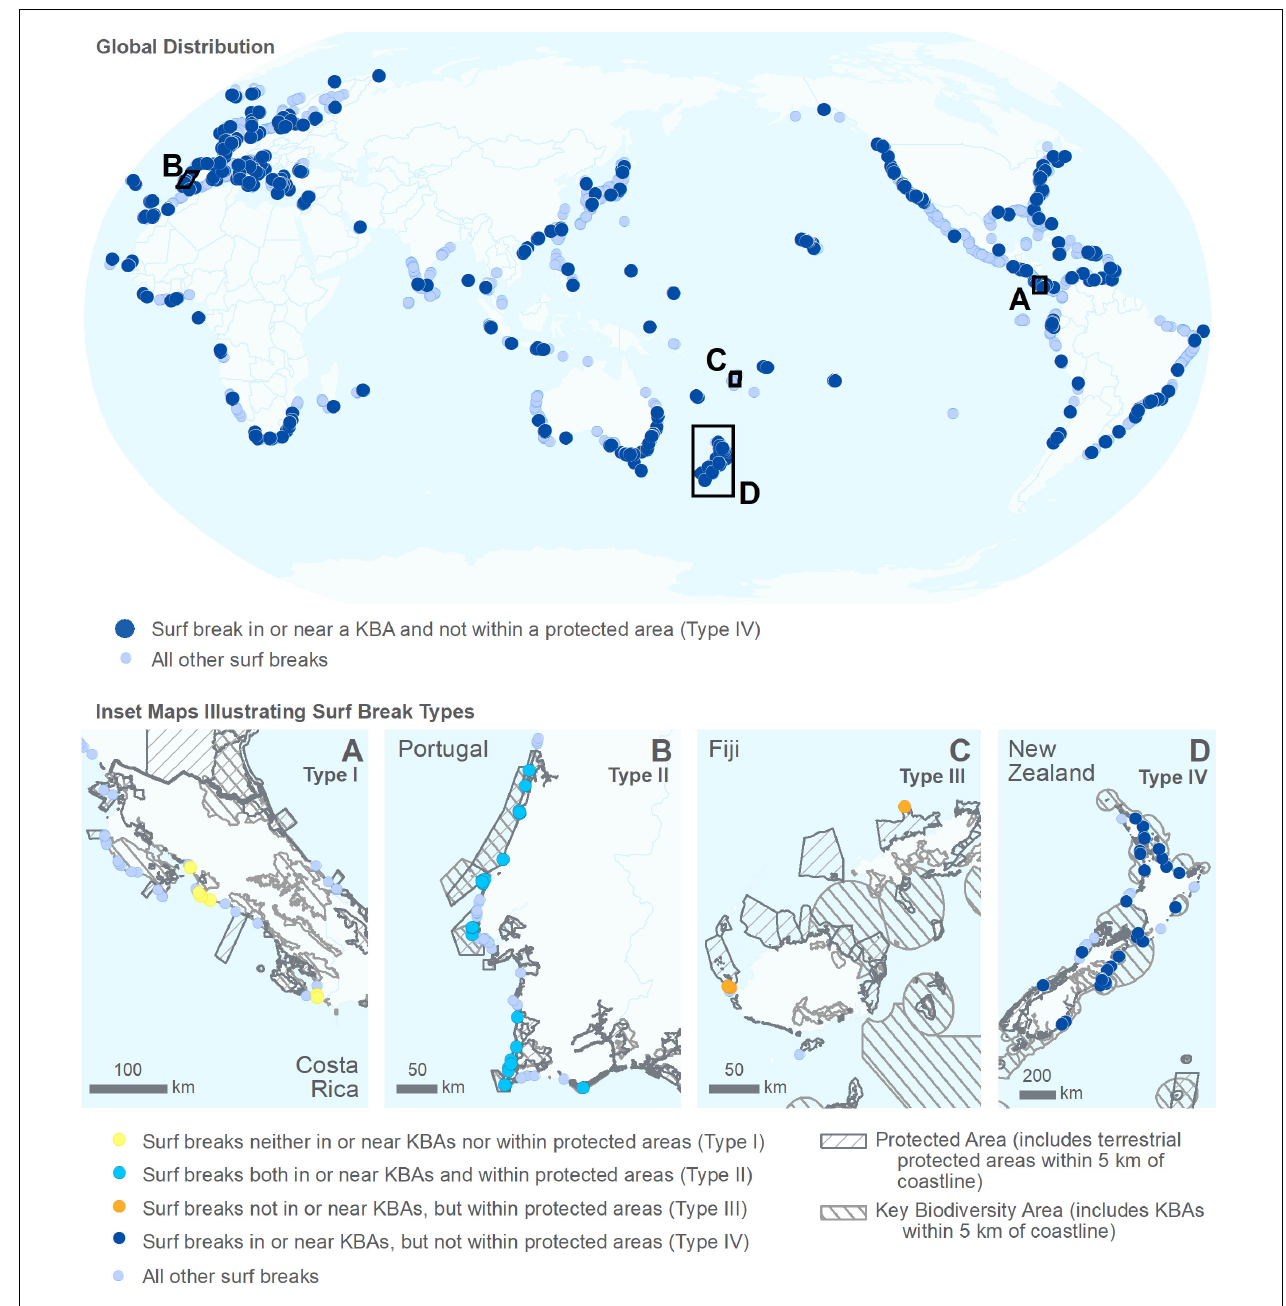
FIGURE 1 | Global distribution of surf breaks illustrating co-beneficial conservation opportunities, where protection of currently unprotected marine areas could benefit surfing resources and biodiversity. Further analysis of the spatial occurrence of surfing resources, biodiversity areas, and protected areas yields a typology of four Types of surf breaks: (I) not within either a KBA or protected area, (II) within both a KBA and a protected area, (III) not within a KBA but within a protected area, and (IV) within a KBA but not within a protected area. The global map highlights Type IV. Inset maps illustrate four example countries whose surf breaks currently comprise a majority of each type: (A) Costa Rica (Type I), (B) Portugal (Type II), (C) Fiji (Type III), and (D) New Zealand (Type IV). Any surf break’s current type could change based on a modification of its country’s protected area regime or subsequent change in biodiversity status (or wholesale loss of the surf break